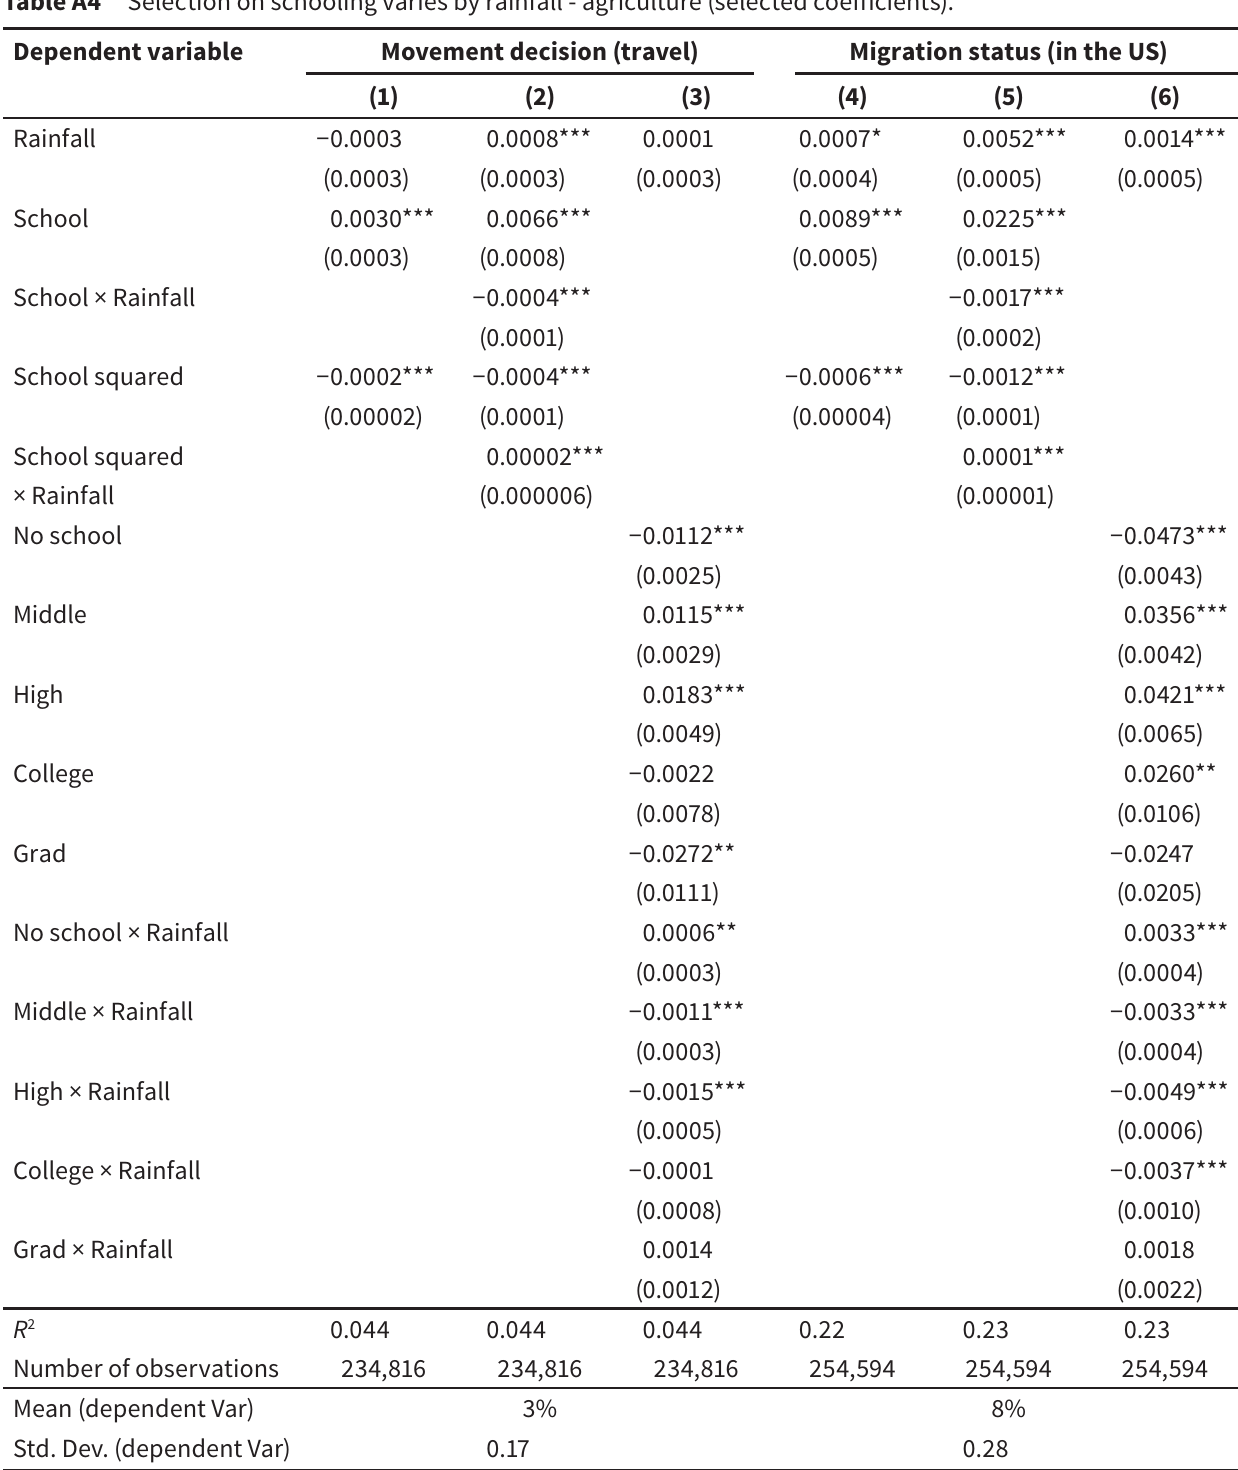
Selection on schooling varies by rainfall - agriculture (selected